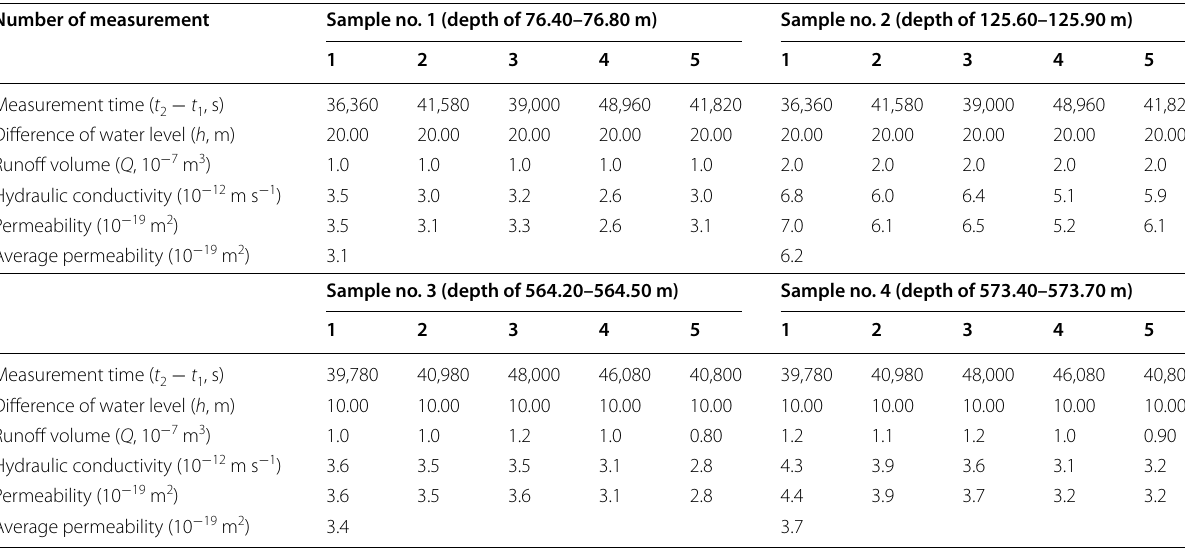
Permeability was measured five times for each sample